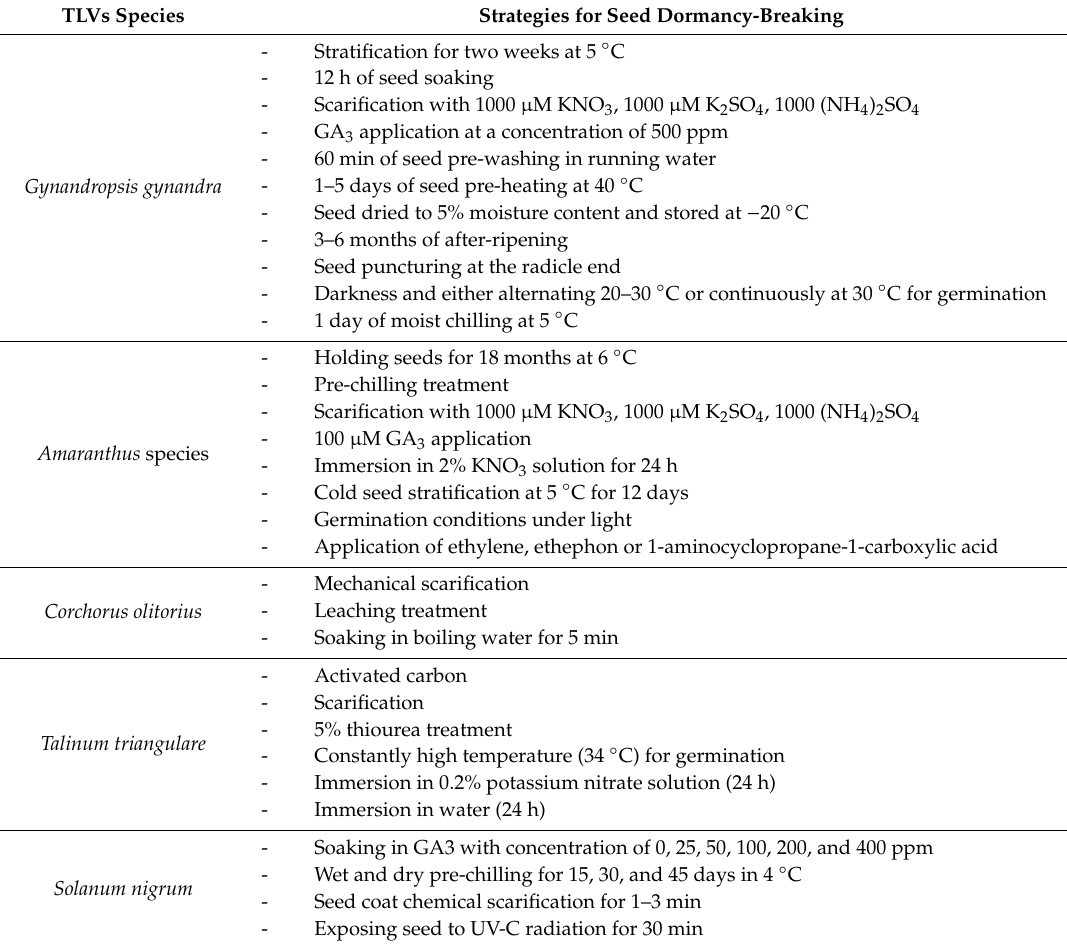
Table 2. Various strategies for seed dormancy-breaking in African leafy vegetables ( Gynandropsis gynandra , Amaranthus spp., Corchorus olitorius , Talinum triangulare , Solanum nigrum